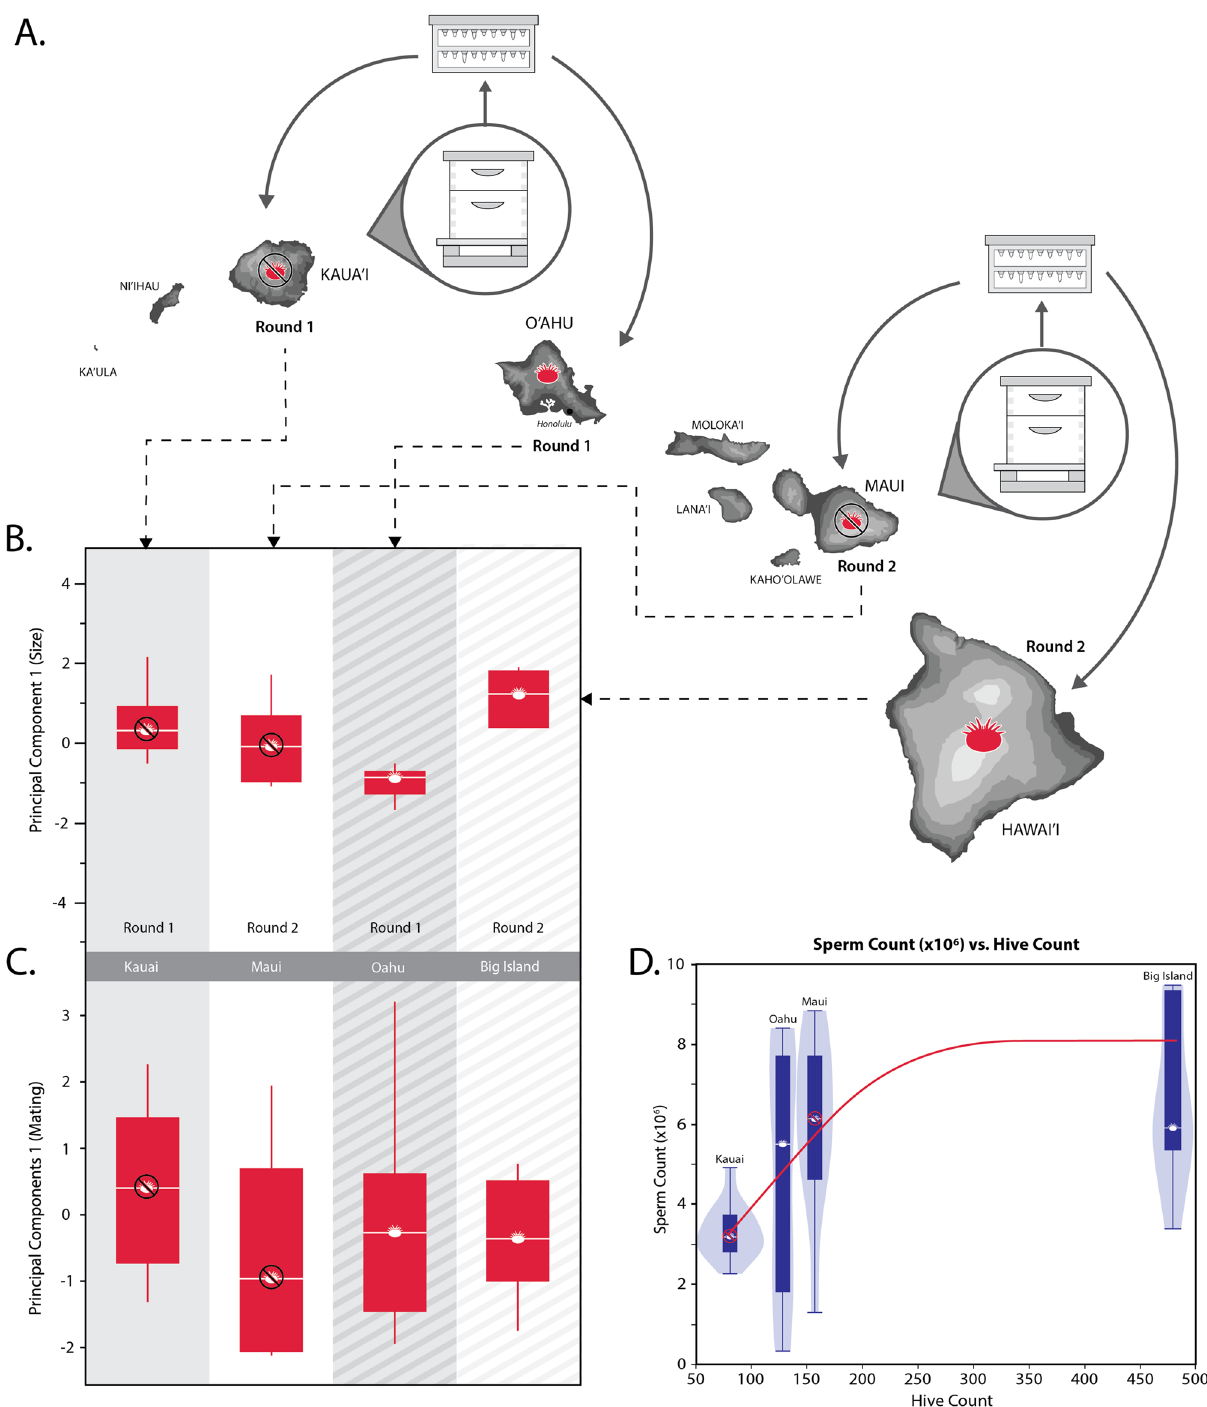
Figure 1. ( A ) Map of the Hawaiian Islands where the experimental queens were reared and mated. Two rounds of young worker larvae were separately raised as queens on varroa-free islands (Kaua‘i and Maui, respectively) then placed in nucleus hives on either the same island or a varroa-infested island (Hawai‘i and O‘ahu, respectively) for the queens to mate. ( B ) Principal Component 1 for queen body size—with loading variables of mean weight (mg), head width (mm), thoracic width (mm), and spermatheca diameter—were not significantly different among the queens mated on the four islands. ( C ) Principal Component 1 for mating quality—with loading variables of mean % sperm viability, sperm count (× 10 6 ), observed mating number, and effective paternity frequency ( m e )—were also not significantly different among the four populations of queens. ( D ) There was a significant correlation between queen stored sperm count (× 10 6 ) and managed hive number within a 4.83 km (3-mile) radius of the apiaries where the queens were